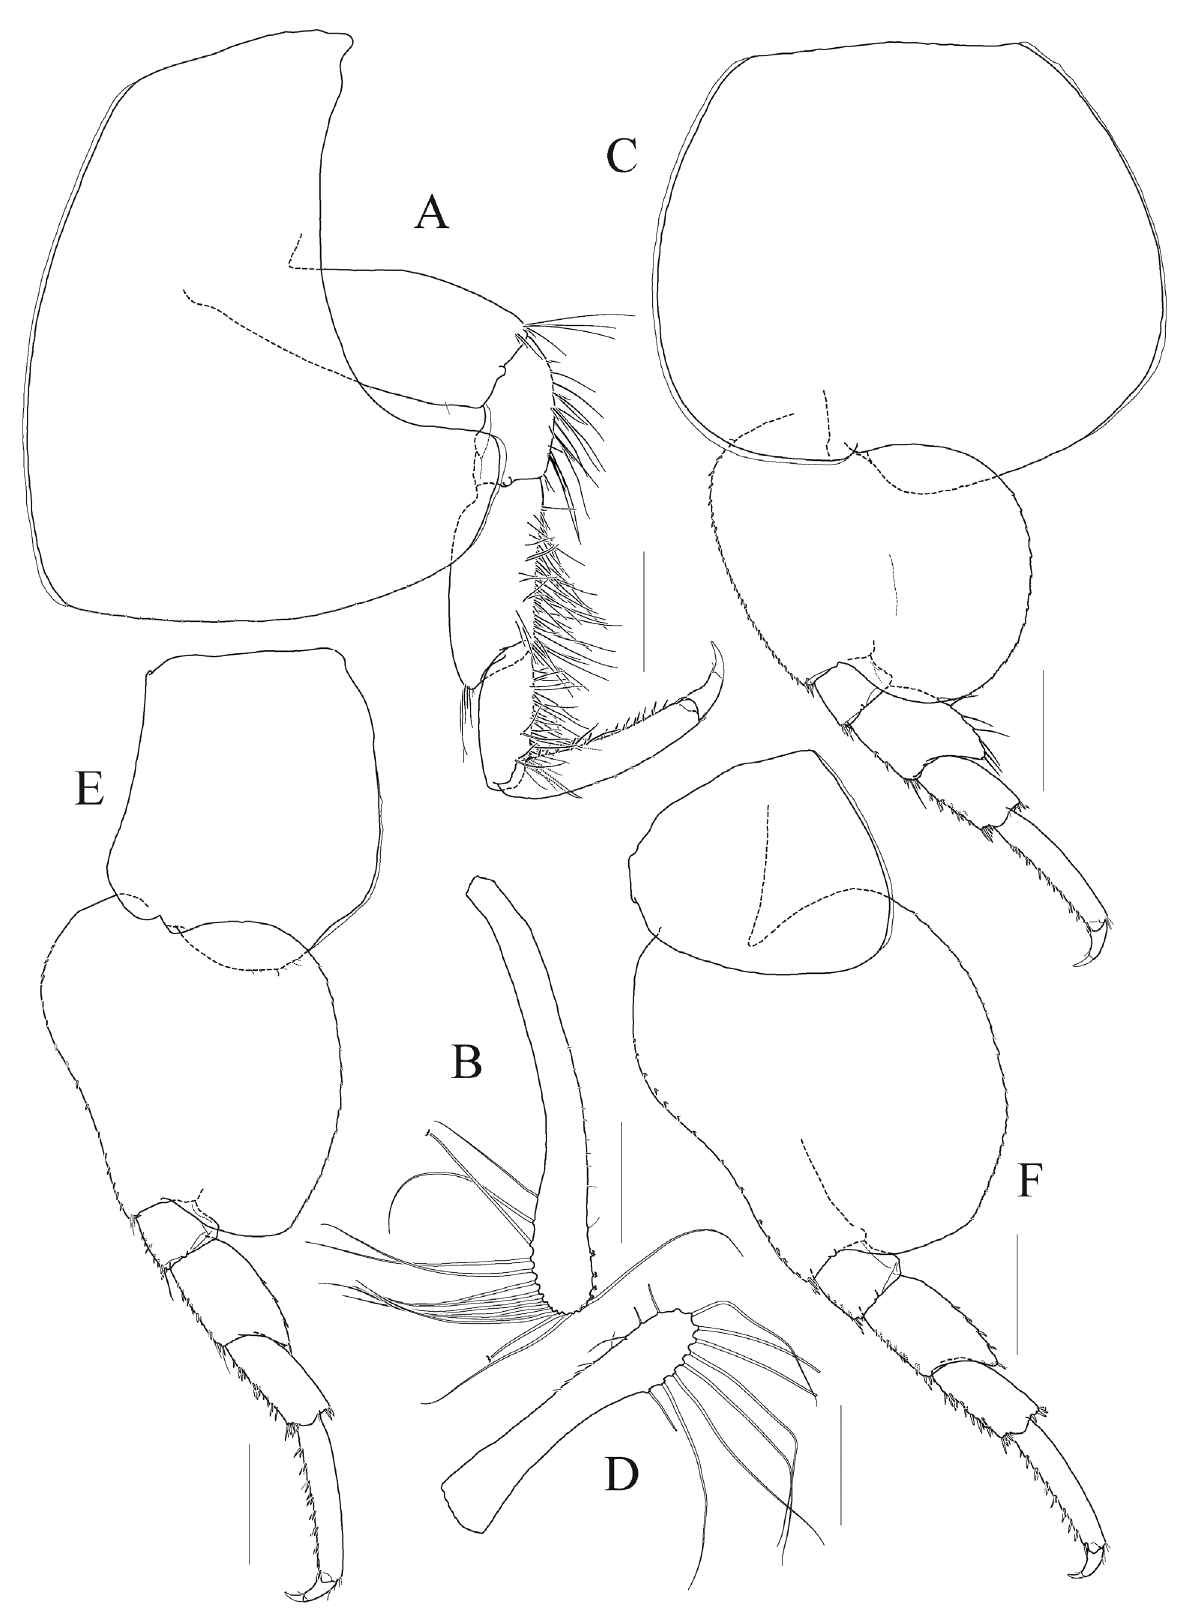
Figure 4. Pseudorchomene boreoplebs sp. n., holotype female (27.1 mm), NIBRIV0000806535. A pereopod 4; B oostegite of pereopod 4; C pereopod 5; D oostegite of pereopod 5; E pereopod 6; F pereopod 7. Scale bars 1.0 mm ( A–F